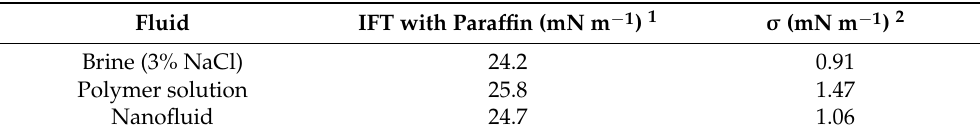
Table 1. Interfacial tension.